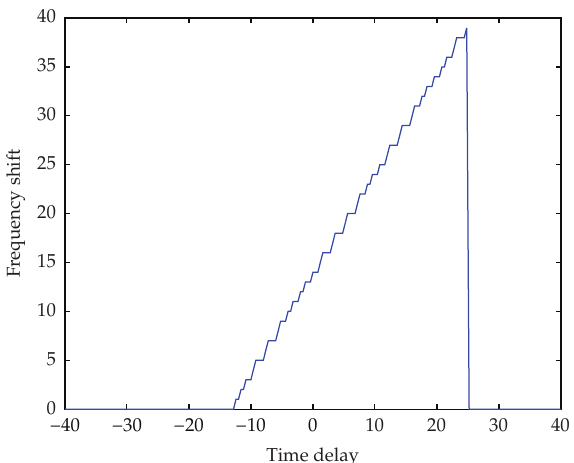
Figure 6: Search for the peak value in the time-frequency plane of